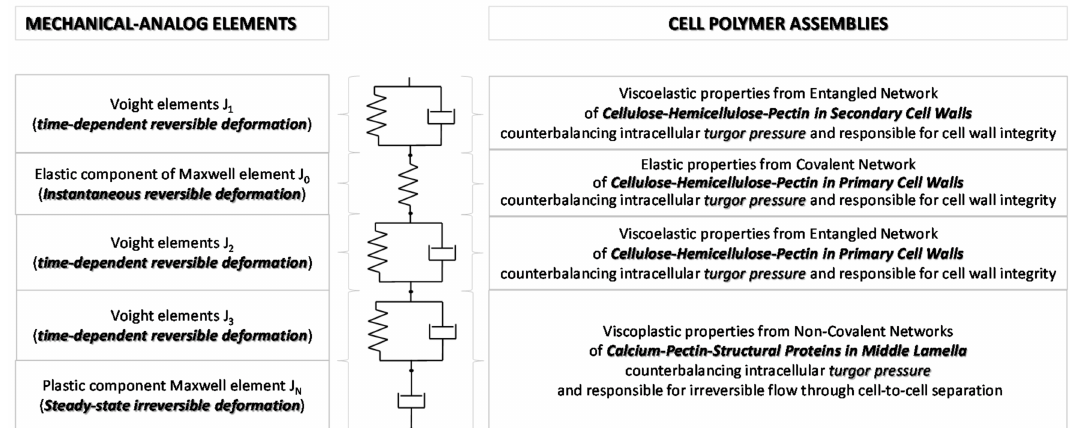
Scheme 2. Tailored Burger’s array illustrating the hypothesis structure-function relationships among the polymeric assemblies at cell wall and middle lamella